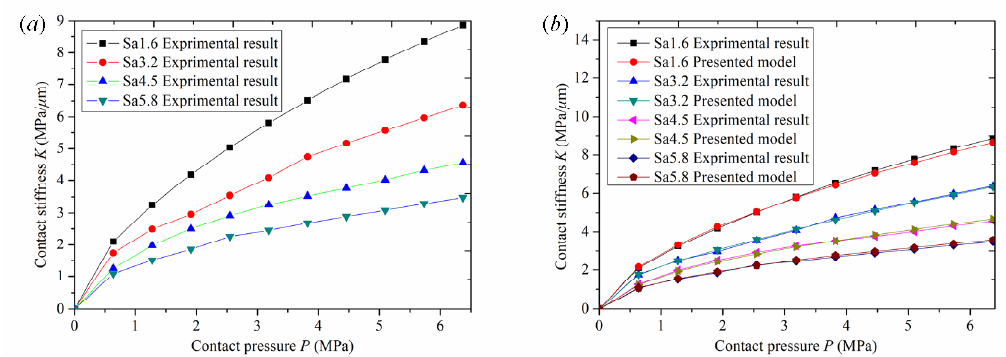
Figure 8. Normal contact stiffness: ( a ) the experimental results; ( b ) comparison between experimental results and the proposed model.